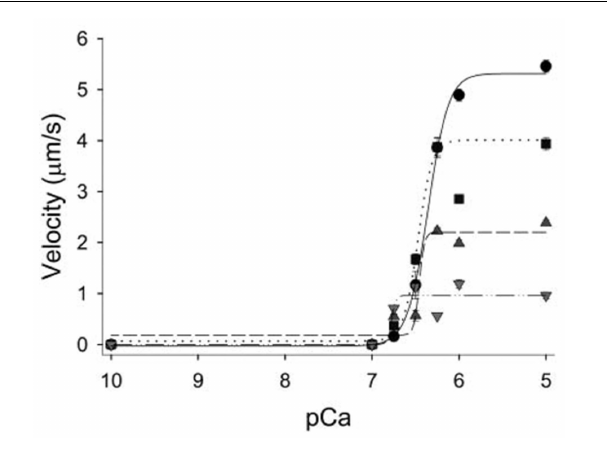
FIGURE 7 | Effect ofADP on the velocity–pCa relationship in vitro . Regulated actin filament velocities plotted as a function of increasing ADP concentrations.The ADP levels were increased from 0.5mM ADP (squares, dotted line), to 2mM (triangles up, dashed regression), and 5mM (triangles down, dash-dot regression) and compared to control experiments with no added ADP (circles, solid regression). Elevated ADP significantly decreased maximal velocity but increased the pCa 50 of the thin filament in a concentration-dependent manner. Figure modified from Gorga et al., 2003, reprinted with permission from Cell